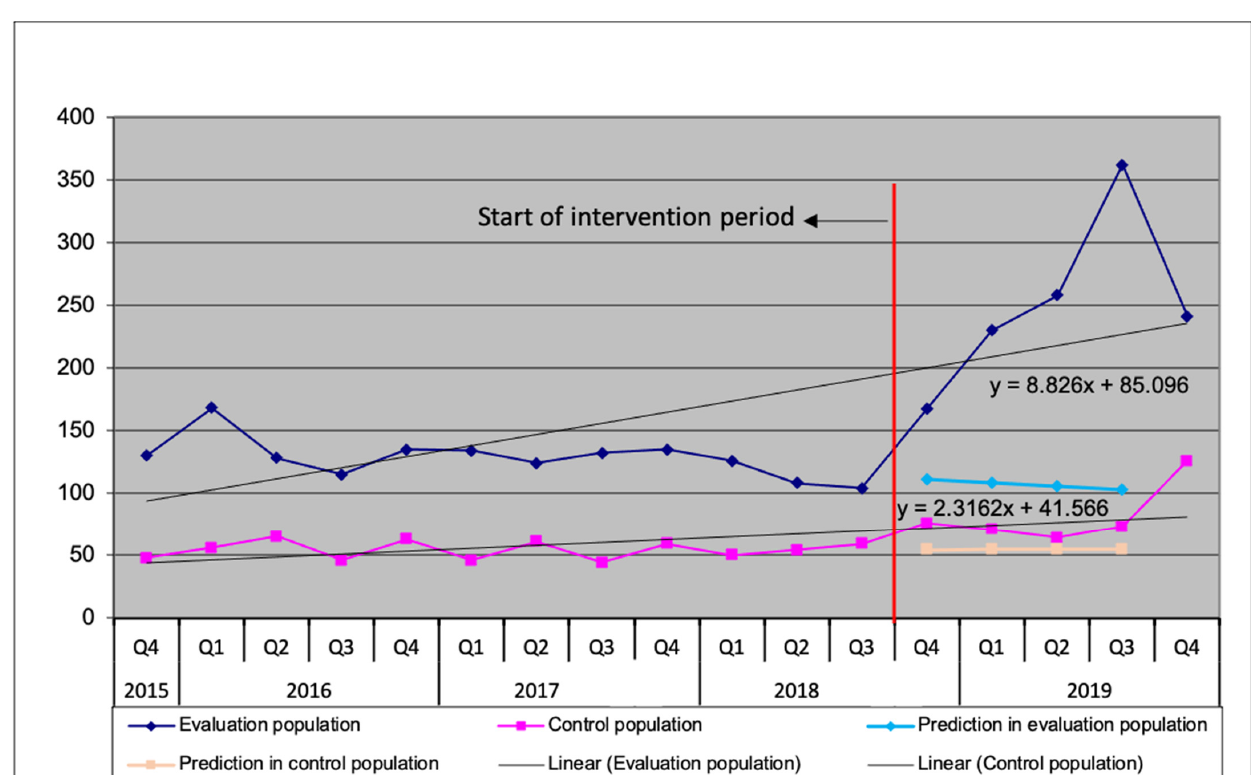
Figure 2. All forms TB cases during baseline and implementation periods and expected values during implementation period based on historical 3-year linear trend. Table 4 outlines the results of the intervention by each approach employed by ECEWS.